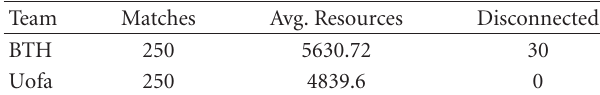
Table 1: Experiment results from the Collaborative Pathfinding game in 2008 years’